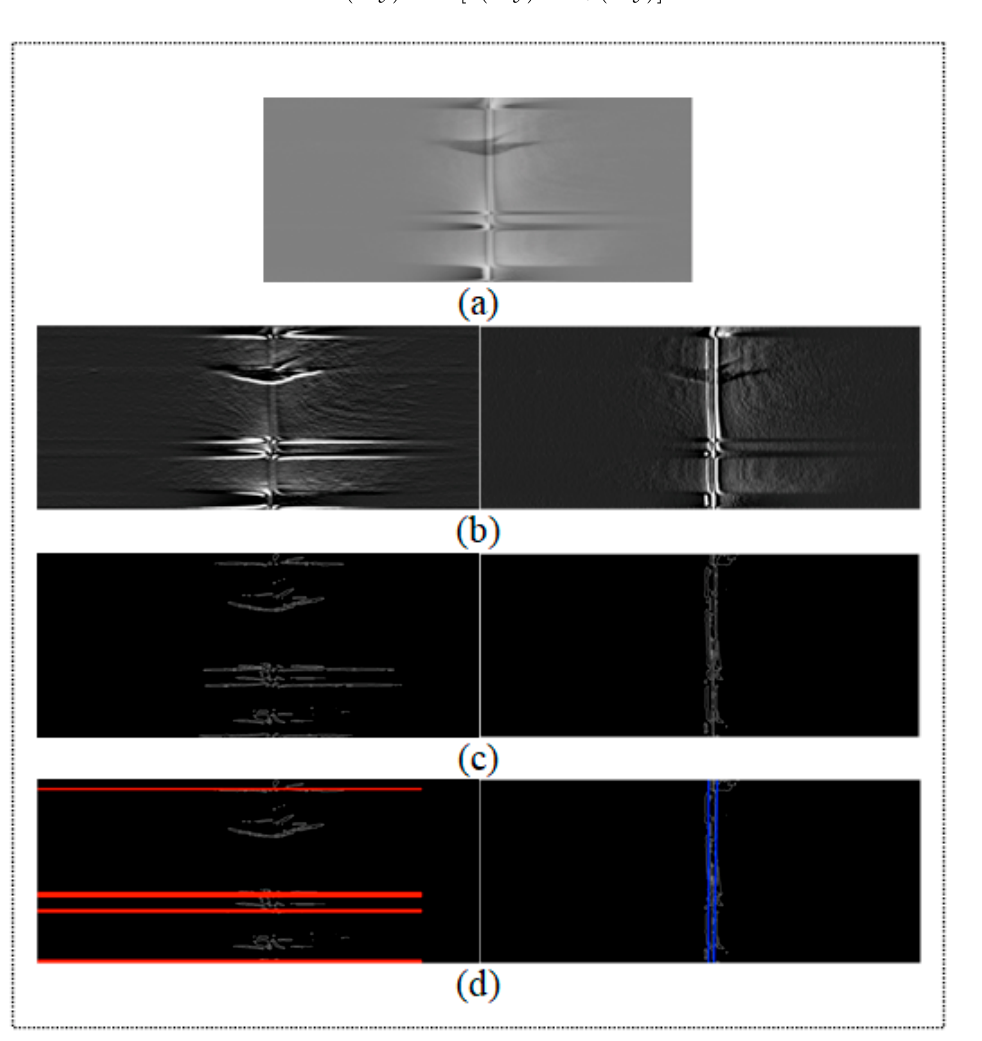
Figure 4. Example of denoising process: ( a ) Original SLAR image; ( b ) Texture pattern obtained by using Gabor filters to detect noise caused by aircraft maneuvers; ( c ) Pixel edges with maximum gradient; ( d ) Straight lines from Hough Transform (k-means has not yet been applied to this point).